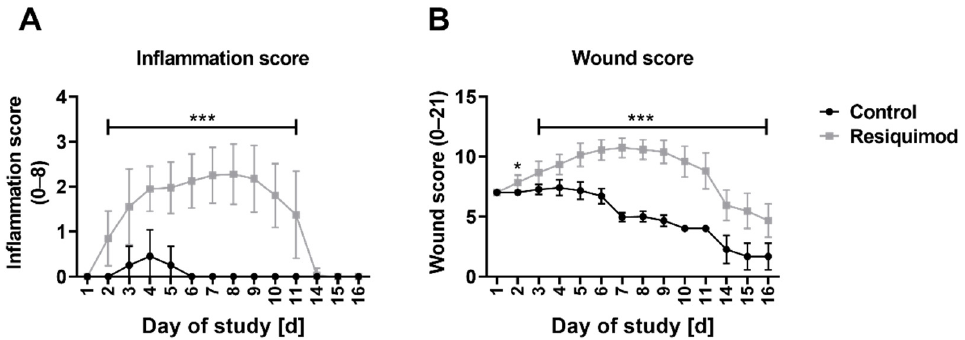
Figure 3. Inflammation score and wound score over the course of the experiment. ( A ) The inflammation score showed a highly significant difference between control and resiquimod-induced wounds. ( B ) The overall wound score includes the area score as well as the inflammation score. Data are presented as mean (dot) ± standard deviation (whiskers) (n = 20 for control wounds; n = 40 for resiquimod-induced wounds). Data shown as mean ± SD. Statistical significance has been determined by 2-way ANOVA and corrected for multiple comparisons using the Sidak method. *** ( p < 0.001).